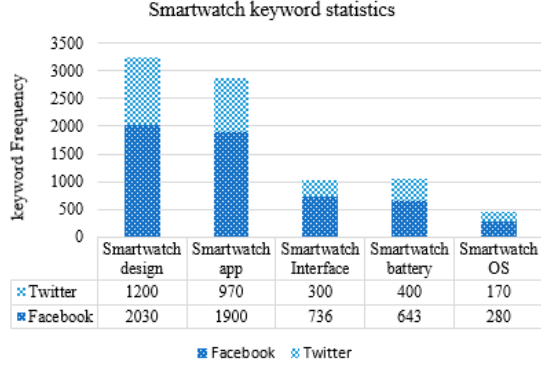
Figure 6. Statistics of smartwatch domain keywords.